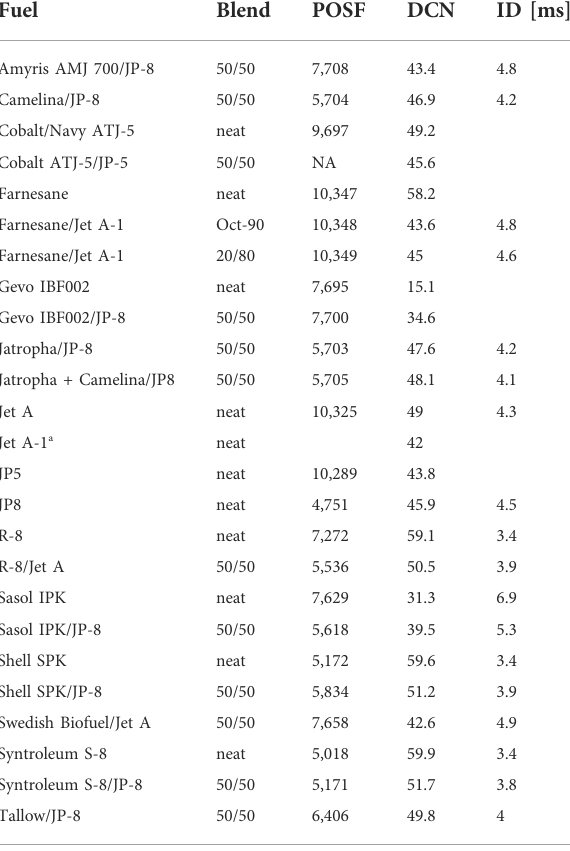
TABLE 4 Autoignition characteristics for selected fuels (Hutzler et al.,